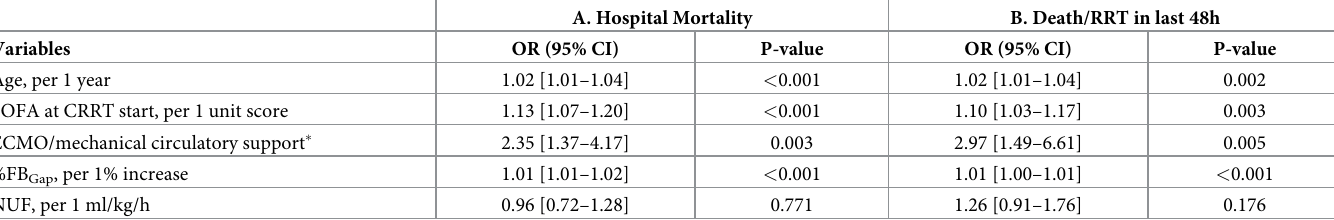
Table 3. Multivariable logistic regression model of %FB Gap and NUF as the independent variables and a) hospital mortality and b) death or RRT in the last 48 h of hospi- talization as the dependent variables. A. Hospital Mortality B. Death/RRT in last